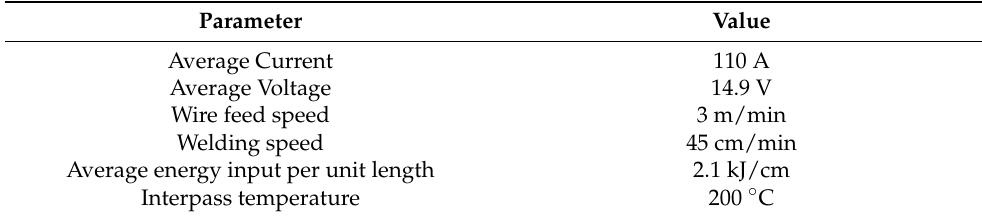
Table 1. Process parameters for the sample manufacturing.